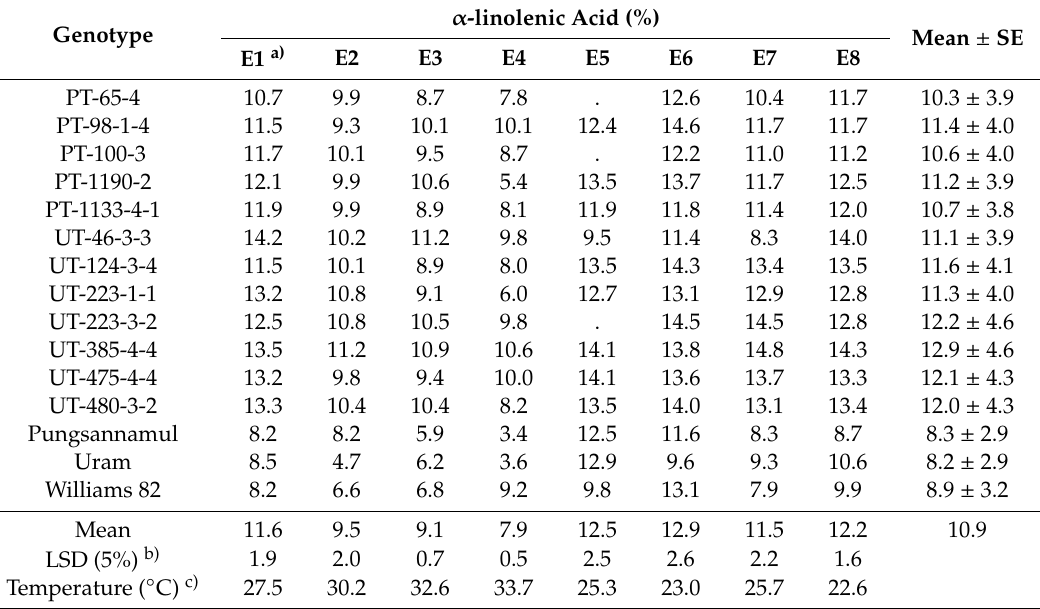
Table 5. Mean α -linolenic acid concentration for twelve soybean genotypes with elevated α -linolenic acidconcentrationandthreesoybeancultivarswithnormal α -linolenicacidgrownineightenvironments over two